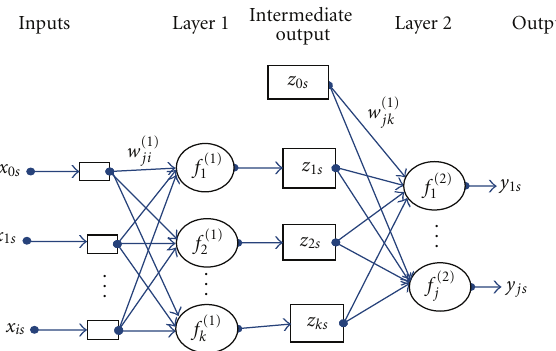
Figure 3: Two-layer feedforward neural network of the SBLLM.